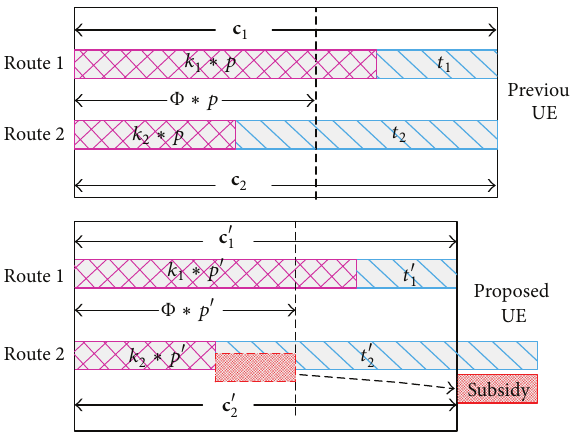
Figure 1: The diagram of the two types of UE